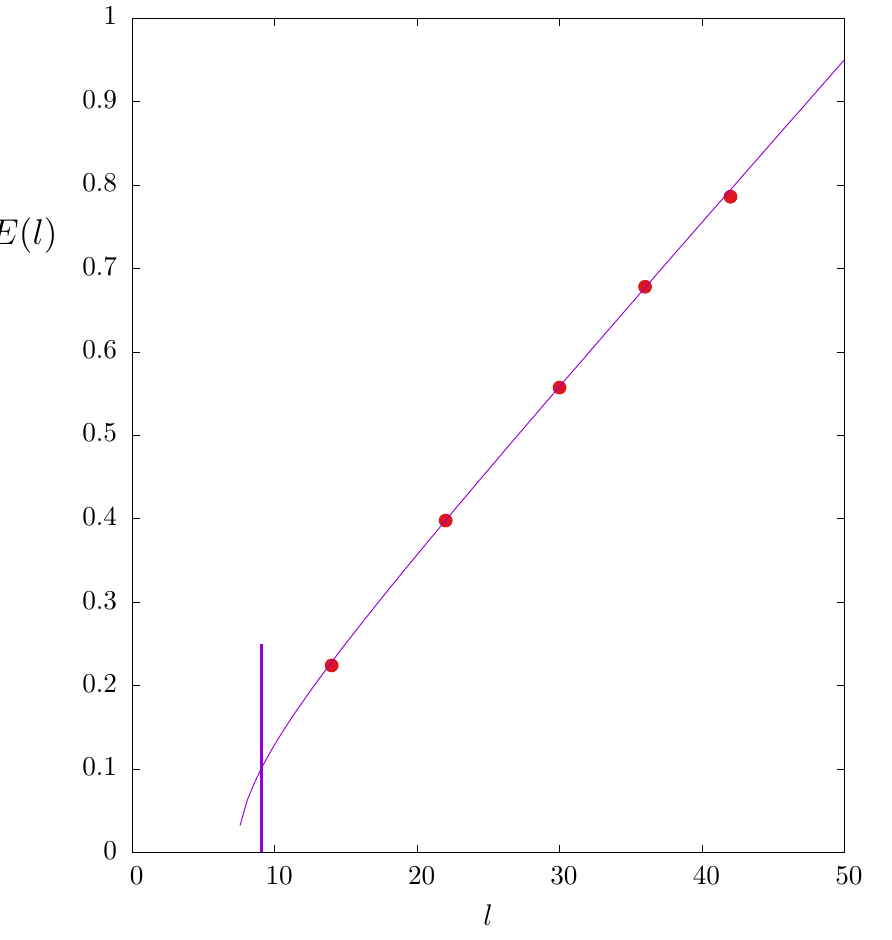
Figure 12 . Ground state energy of a (cid:13)ux tube of length l in SO(5) at (cid:12) = 27 : 5. Nambu-Goto (cid:12)t shown. Vertical line gives location of the decon(cid:12)ning